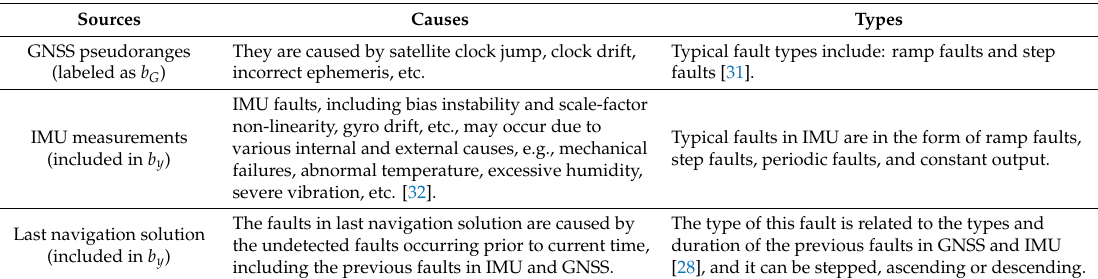
Table 2. Sources, causes, and types of the faults in the integration